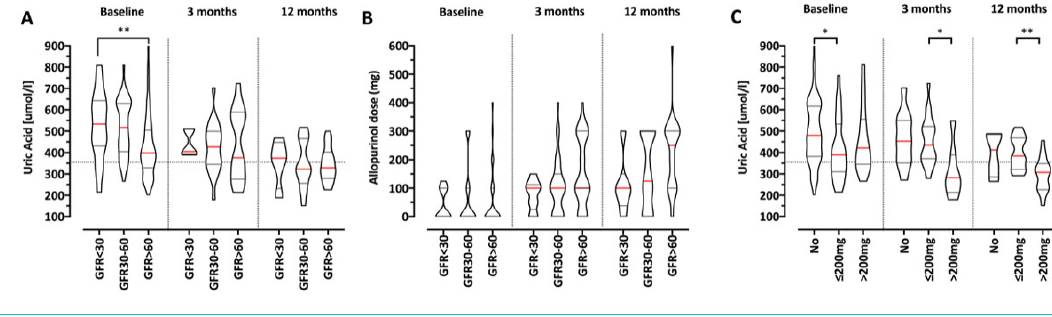
Figure 2: Renal function, SUA levels and allopurinol dosage at baseline and follow-up. Violin plots (red lines = medians) of (A) Glomerular fil- tration rate (GFR in ml/min/1.73 m 2 ) and corresponding SUA (serum uric acid) levels in μmol/l, (B) GFR and corresponding allopurinol dosages (mg/d), (C) Allopurinol dosages and corresponding SUA levels for the 3 time-points of the observation period.